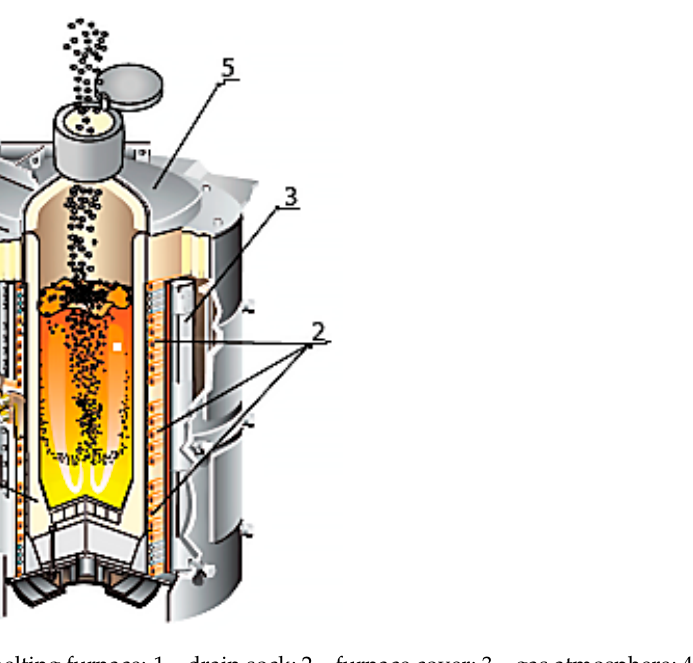
Figure 2. Induction melting furnace: 1—drain sock; 2—furnace cover; 3—gas atmosphere; 4—scrap metal; 5—inductor; 6—case.